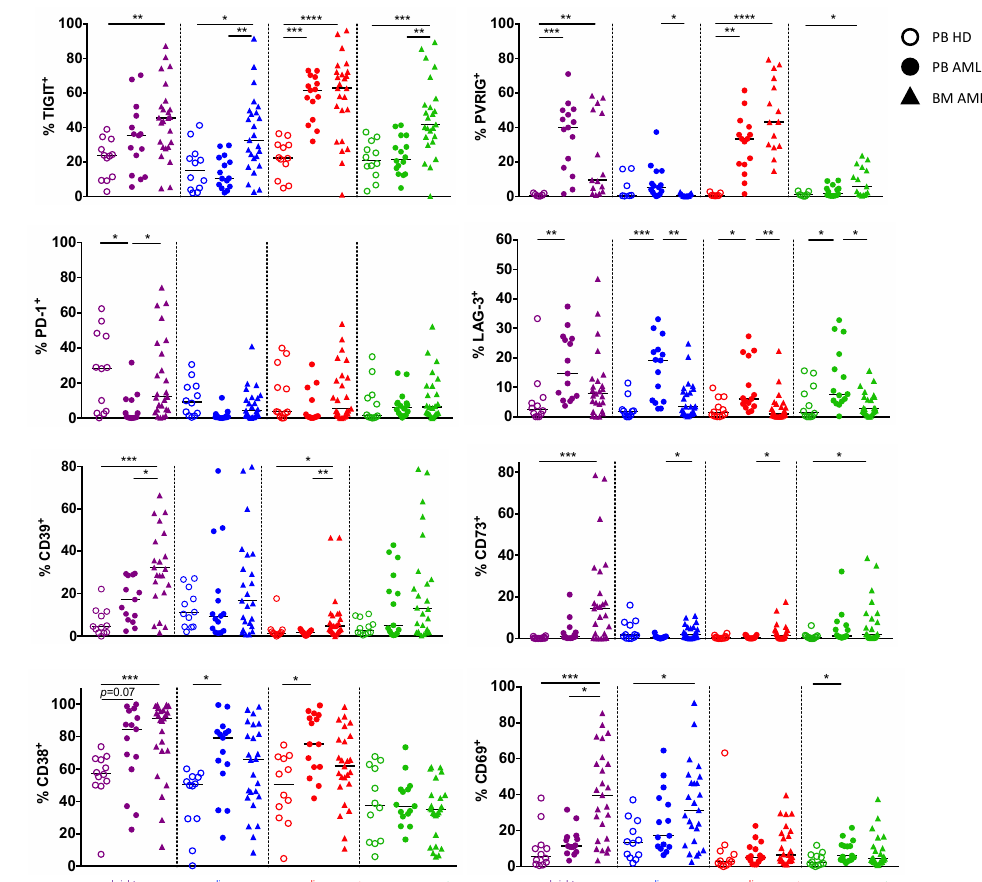
Figure 3. Expression of TIGIT, PVRIG, CD39, and CD38 is related to distinct NK cell populations. The expression of TIGIT, PVRIG, PD-1, LAG-3, CD39, CD73, CD38, and CD69 was compared between the different NK cell subpopulations (CD56 bright CD16 − , CD56 dim CD16 − , CD56 dim CD16 + , and CD56 – CD16 + ) in the peripheral blood (PB, n = 15) and bone marrow (BM, n = 25, except for PVRIG n = 15 due to a converted MFC panel) from patients with AML and the PB from healthy donors (HDs, n = 12, for PVRIG n = 7). Summary data of the expression analyses on NK cell subpopulations are depicted comparing HDs vs. patients with AML. p values were obtained by ANOVA and Kruskal–Wallis test. * p < 0.05, ** p < 0.01, *** p < 0.001, **** p < 0.0001.